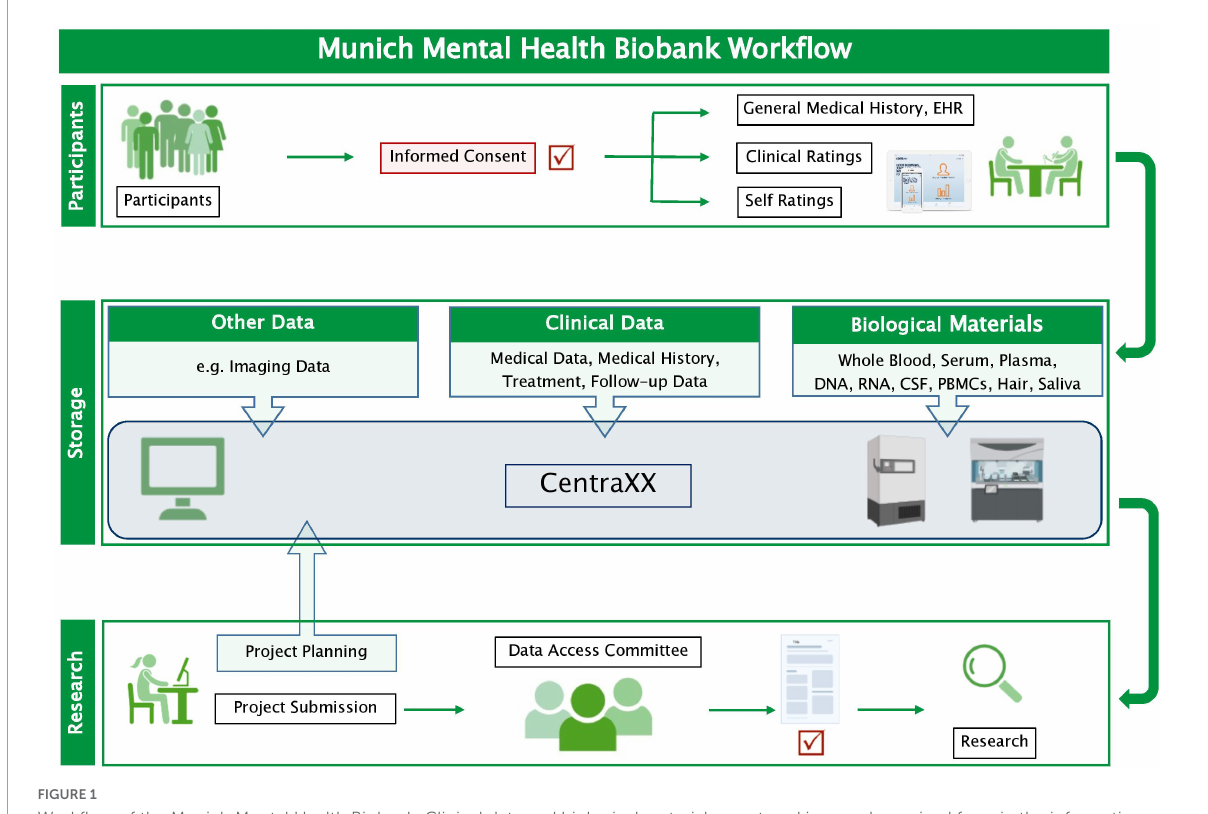
FIGURE1 Workflow of the Munich Mental Health Biobank. Clinical data and biological materials are stored in pseudonymized form in the information management system CentraXX (Kairos GmbH, Bochum, Germany). Biological materials are stored at –80 ◦ C, except for peripheral blood mononuclear cells, which are stored in liquid nitrogen ( Supplementary Table 2 ). Researchers can request data access by completing a request form. If the Data Access Committee approves the request, a material and/or data transfer agreement is signed, and the data and